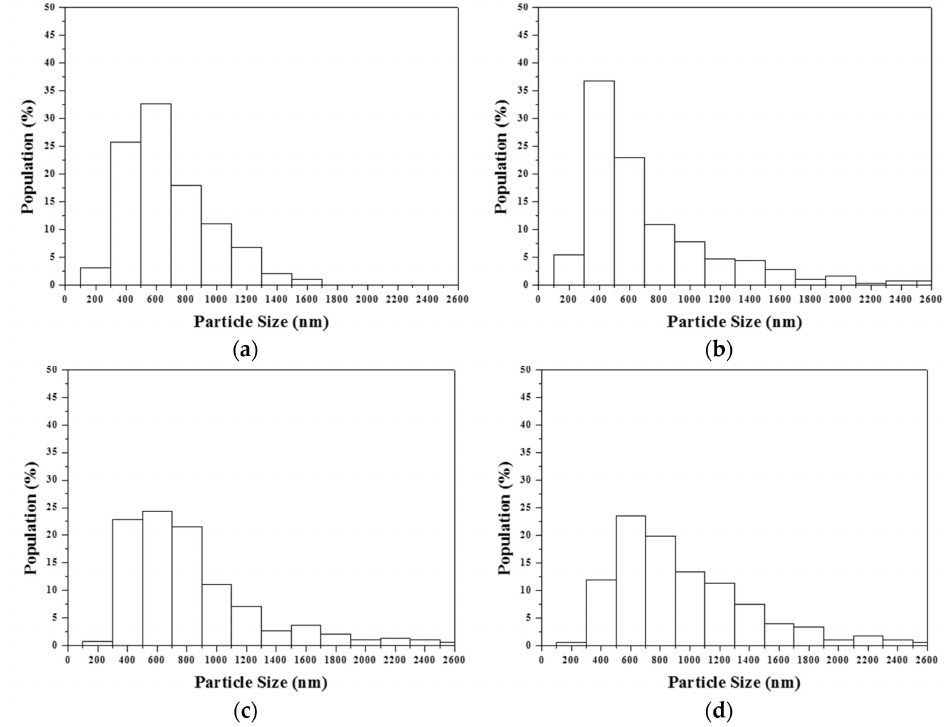
Figure 4. Particle size distributions of MBG particles prepared using various surfactant concentrations of ( a ) 14 wt %; ( b ) 31 wt %; ( c ) 44 wt %; and ( d ) 53 wt